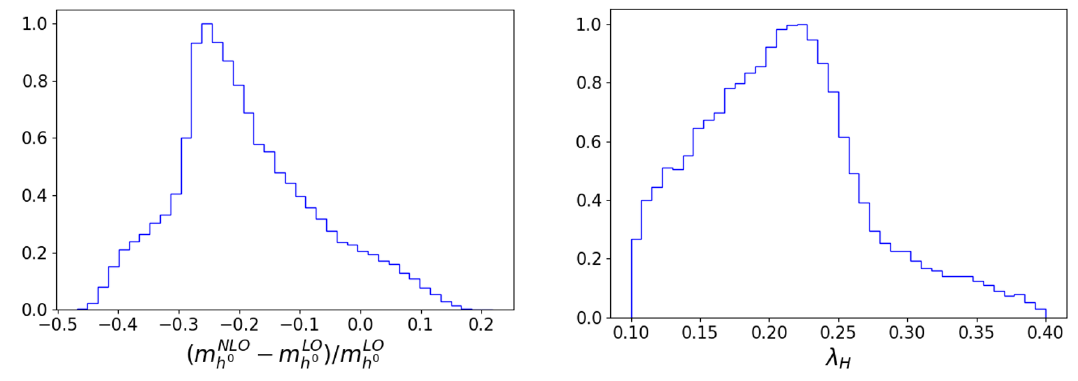
Figure 2 . Left: histogram showing the relative impact of the higher-order corrections to the Higgs-boson mass. Right: resulting distribution of the tree-level parameter λ H when imposing the measured Higgs-boson mass. Both distributions are based on a sample of about 80.000 phenomeno- logically viable parameter points.